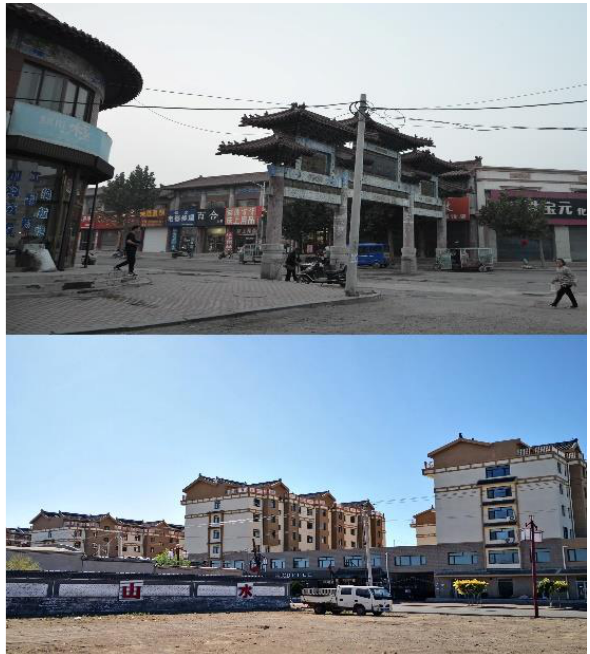
Figure 11. Contemporary buildings with ‘traditional style’ in Xiongyue and